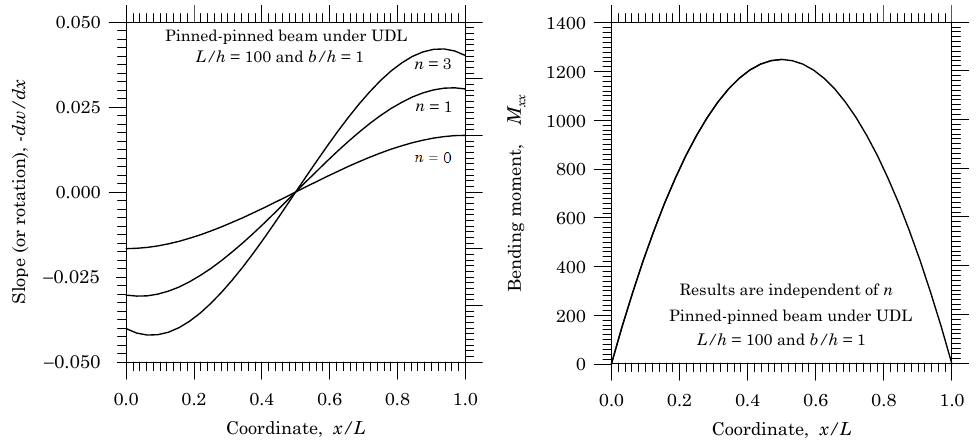
Figure 2. Plots of maximum displacements u ( x ) and w ( x ) versus ξ = x / L for pinned-pinned FGM beams under uniformly distributed transverse load.